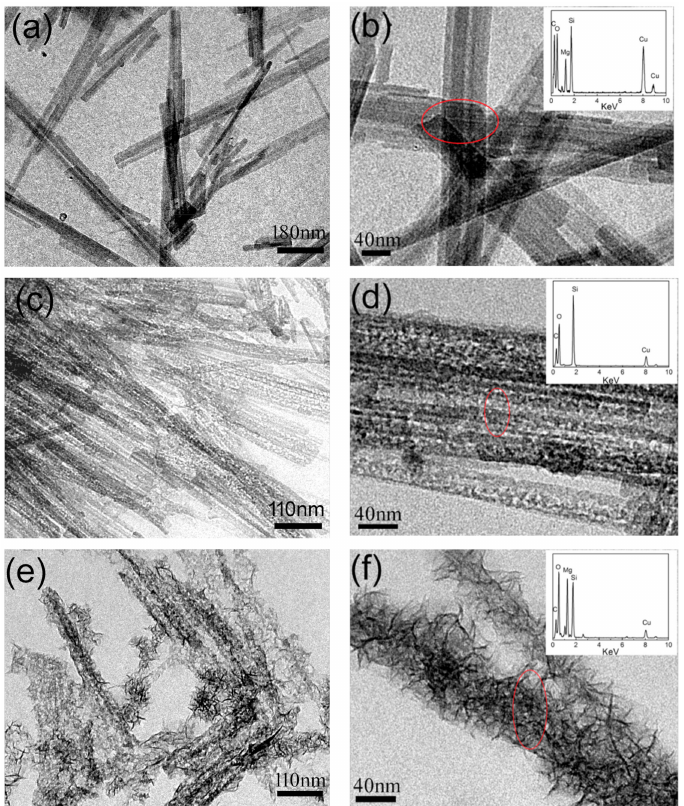
Figure 1. Typical TEM images of raw sepiolite ( a , b ), acid-activated sepiolite ( c , d ), and sepiolite modified by sequential acid–base treatment ( e , f ). Insets in panels b, d, and f are the corresponding energy dispersive X-ray spectroscopy (EDX) spectra. The red ellipses in Figure 1b,d,f indicate the areas of EDX